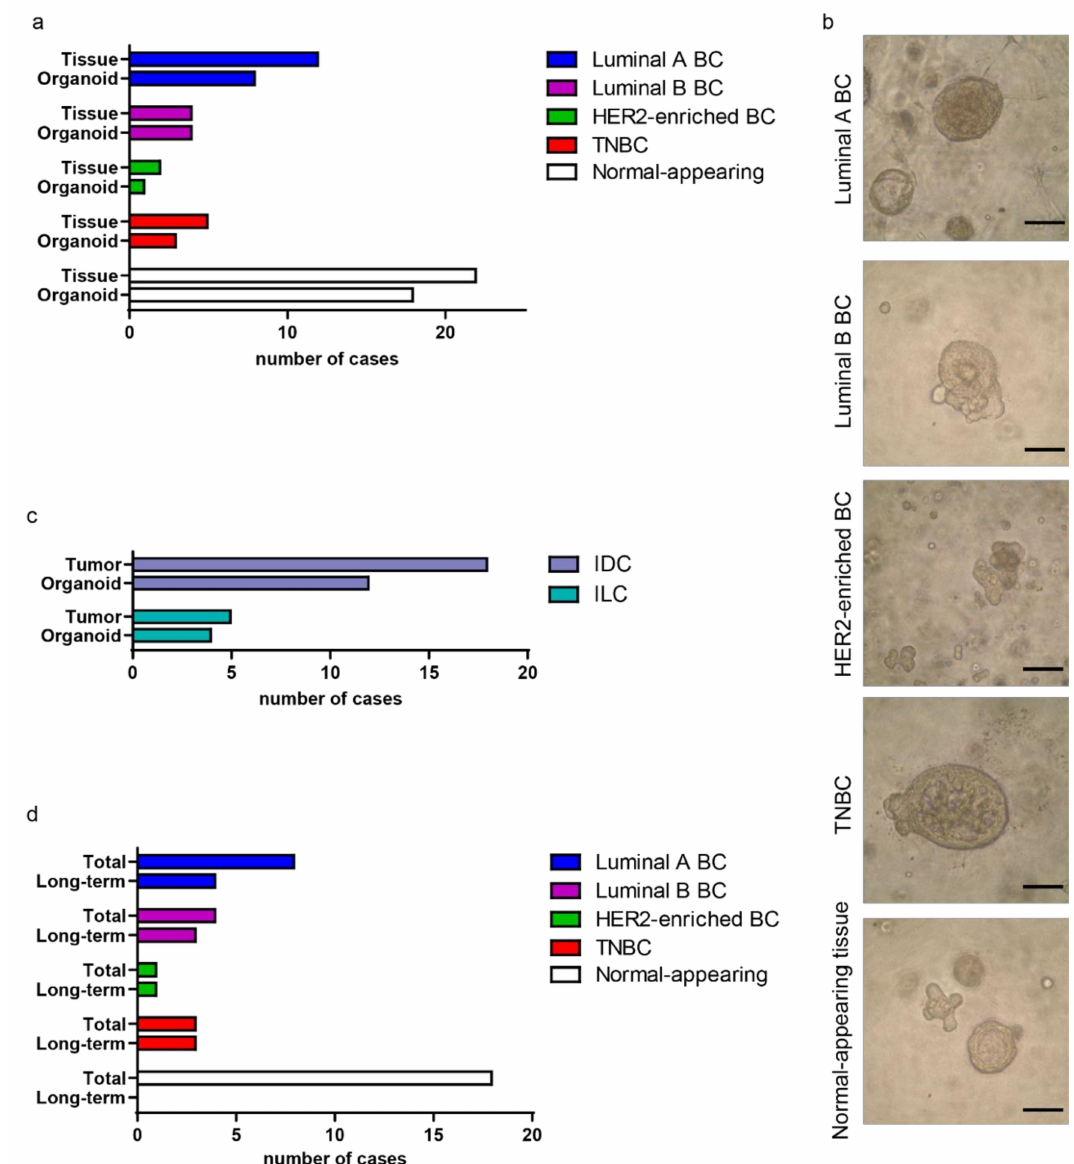
Figure 1. Generating a collection of organoids from primary breast cancers (BCs). ( a ) Histogram representing the stratification of the collected BC, and the derived organoids, based on the molecular subtype. The number of collected normal-appearing adjacent-to-tumor (NAT) specimens and derived organoids is also shown. ( b ) Representative images of organoids derived from BC of di ff erent molecular subtypes and from NAT tissue. Scale bar, 100 µ m. ( c ) Histogram representing the stratification of the collected BC, and the derived organoids, referring to the histological subtype; IDC, invasive ductal carcinoma; ILC, invasive lobular carcinoma. ( d ) Histogram depicting the number of PDOs maintained in culture for longer time (Long-term) compared with the total number of established cultures, arranged into the molecular subtype. The number of long-term NAT-derived organoids is also shown. Long-term organoids are defined as organoids maintained for more than 4 weeks in culture (passages ≥ 4). TNBC, triple negative BC; HER2, human epidermal growth factor receptor